Question: Author a descriptive caption for the visualization shown.
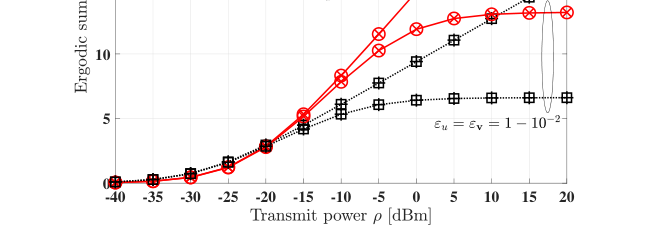
Answer: Theoretical (31), (37) and simulation comparison of the ergodic sum-rate versus the transmit power under different hardware quality factor for the IOS-assisted systems based on the MS protocol and the TS protocol, respectively.